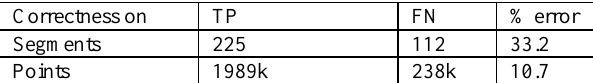
Table 2 Correctness on test dataset segmentwise and pointwise